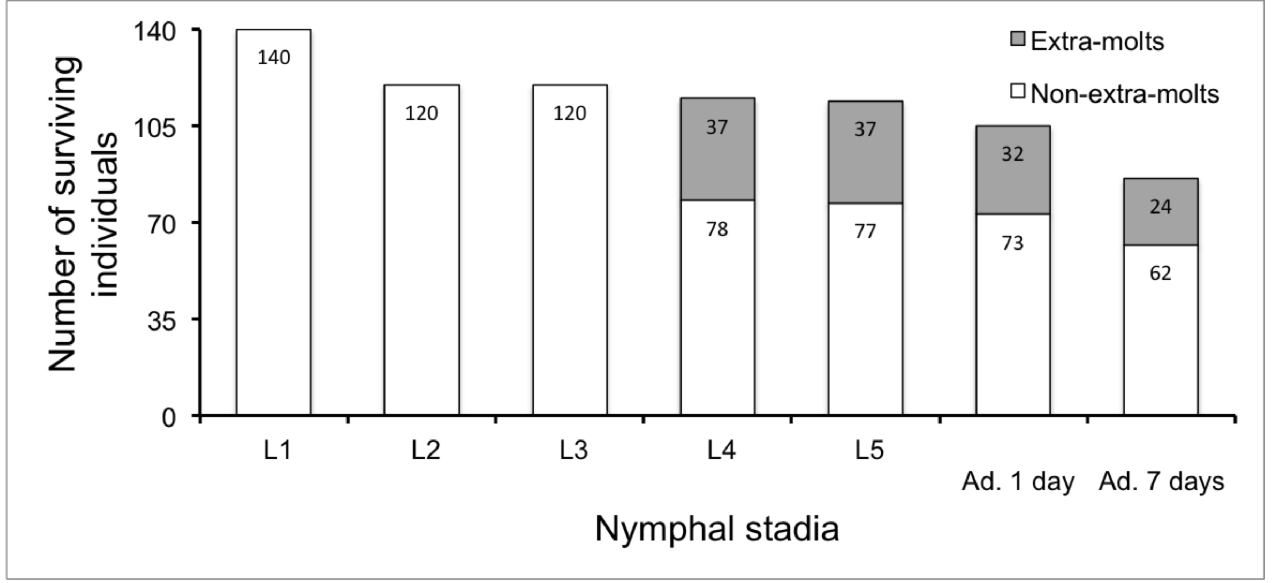
Fig 1. Number of surviving individuals by nymphal stadium and molt strategy. Grey parts represent the fraction of extra molting individuals beyond the L3 stadium. Sample sizes are indicated within bars. NB: we monitored the nymphal growth of the 105 individuals that reached adulthood plus 5 individuals that reached the L5 instar but failed to molt as adults (among 114